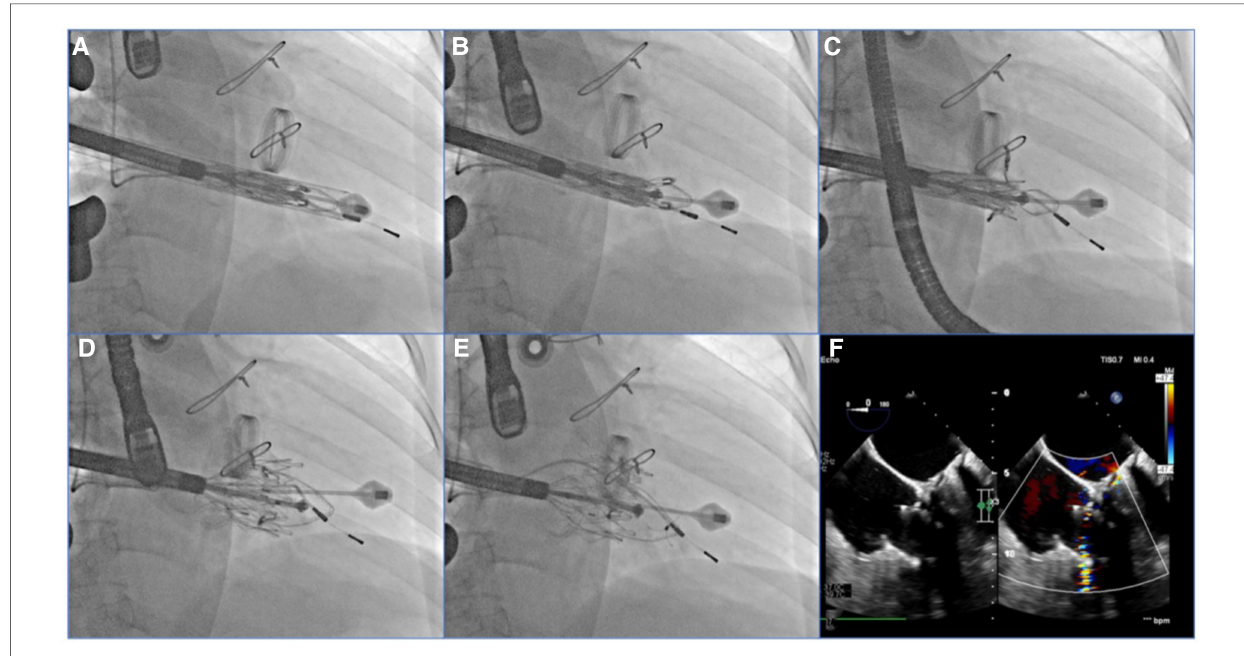
FIGURE 5 TEE and DSA were guided for TTVR. ( A ) DSA showed severe TR on TV. ( B ) The LuX-Valve system guided by TEE was used to deliver the prosthesis to the tricuspid annulus through the right intercostal approach. ( C ) The delivery system fi rst released IVA and two graspers, and TEE guided the anterior lea fl et of the tricuspid valve to be clamped by the grasper. ( D ) The annulus skirt and atrium disc were released in turn, and the position of the implant was adjusted by TEE guidance to ensure that there was no obvious paravalvular leakage. ( E ) The prosthesis was completely released after fi xation with IVA. ( F ) Postoperative TEE showed that TR disappeared immediately. TEE, transesophageal echocardiography; DSA, digital subtracted angiography; TR, tricuspid regurgitation; TV, tricuspid valve; IVA, interventricular